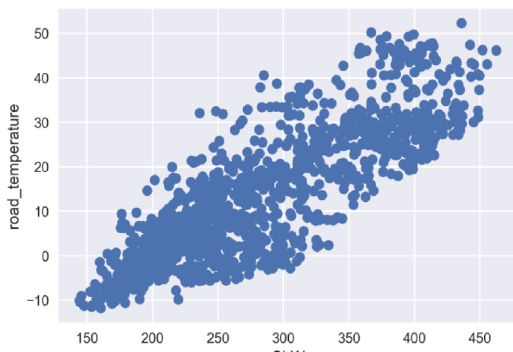
Figure 2. Scatter plot of upward long wave radiation (GLW) and road_temperature